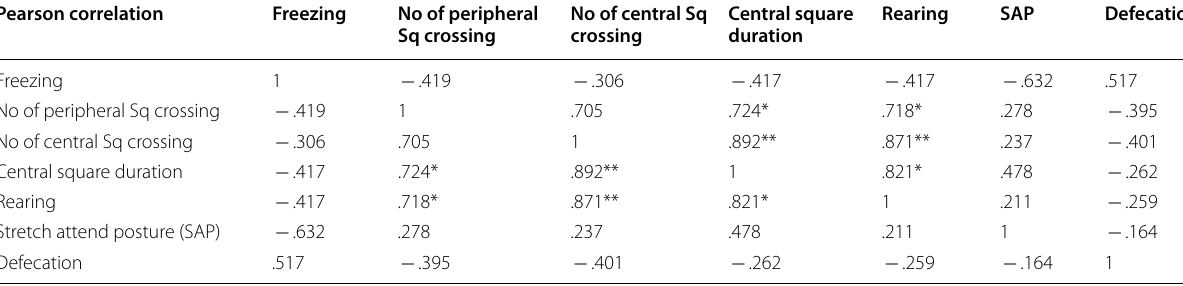
*Correlation is significant at the 0.05 level (2-tailed) **Correlation is significant at the 0.01 level (2-tailed)